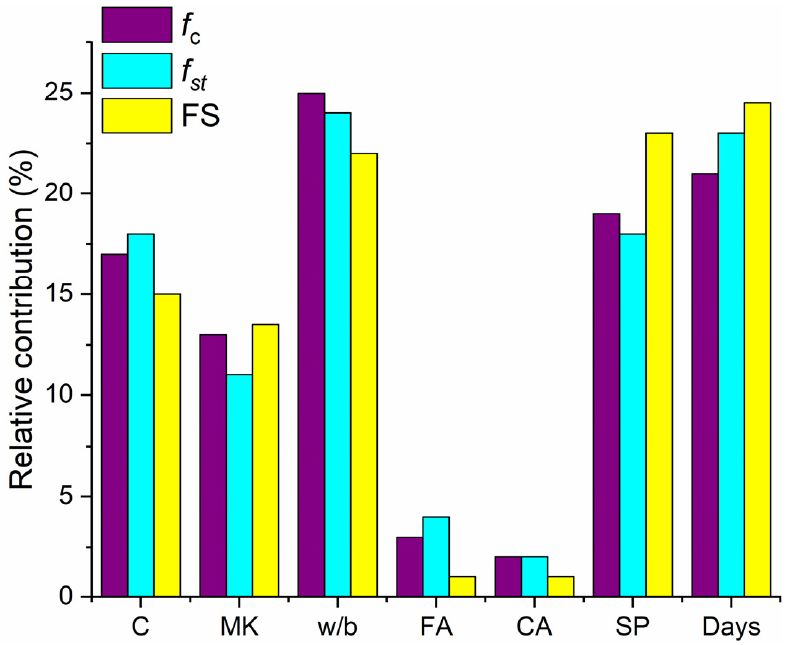
Figure 24. Relative contribution of input parameters to (cid:1858)′ (cid:2913) , (cid:1858) (cid:2929)(cid:2930) and FS.